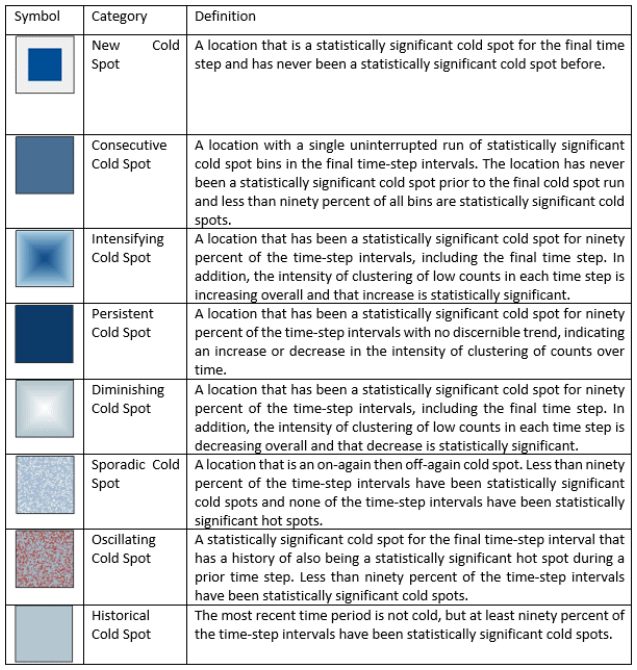
Figure A8. Coldspot categories.